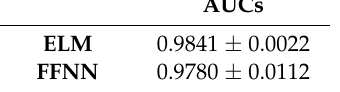
Table 3. Confusion matrix averaged over the 10 random runs.